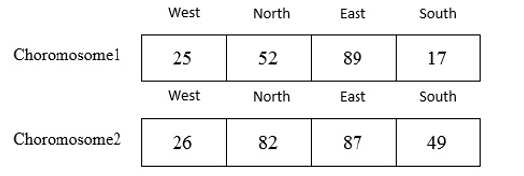
Figure 9. Primary population sample.